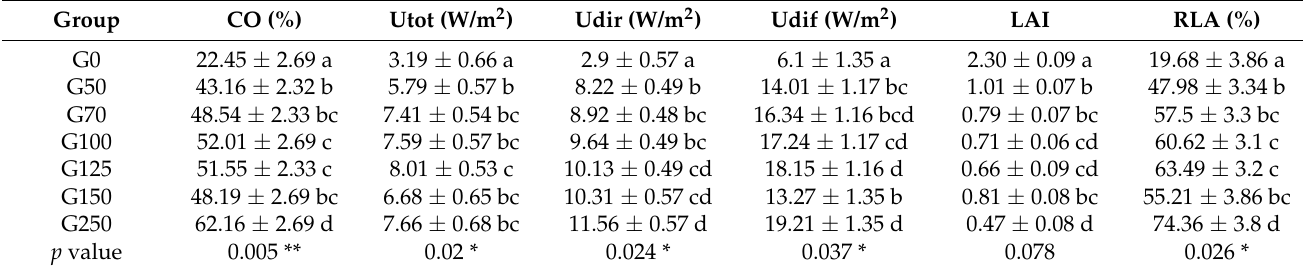
Table 2. Light properties of forest gaps and closed forests (Data are mean ± standard deviation (n = 25)).